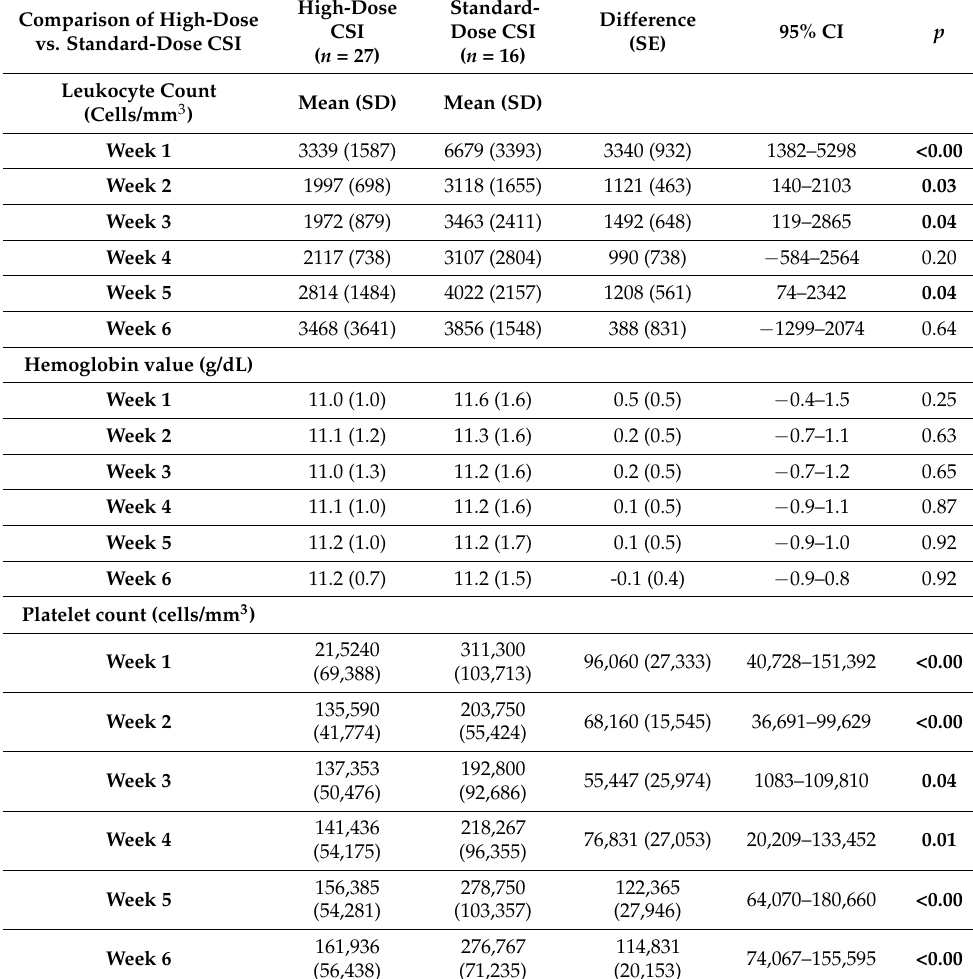
Table 4. Comparison of mean hematological values between patients who receive high-dose CSI (36.0 GyRBE) and standard-dose CSI (23.4 GyRBE), at different timepoints (weeks of treatment), using the independent samples t-test (Welch’s adaptation was used in the case of unequal variances). High-Dose Standard- Comparison of High-Dose CSI Dose vs. Standard-Dose CSI ( n = 27)